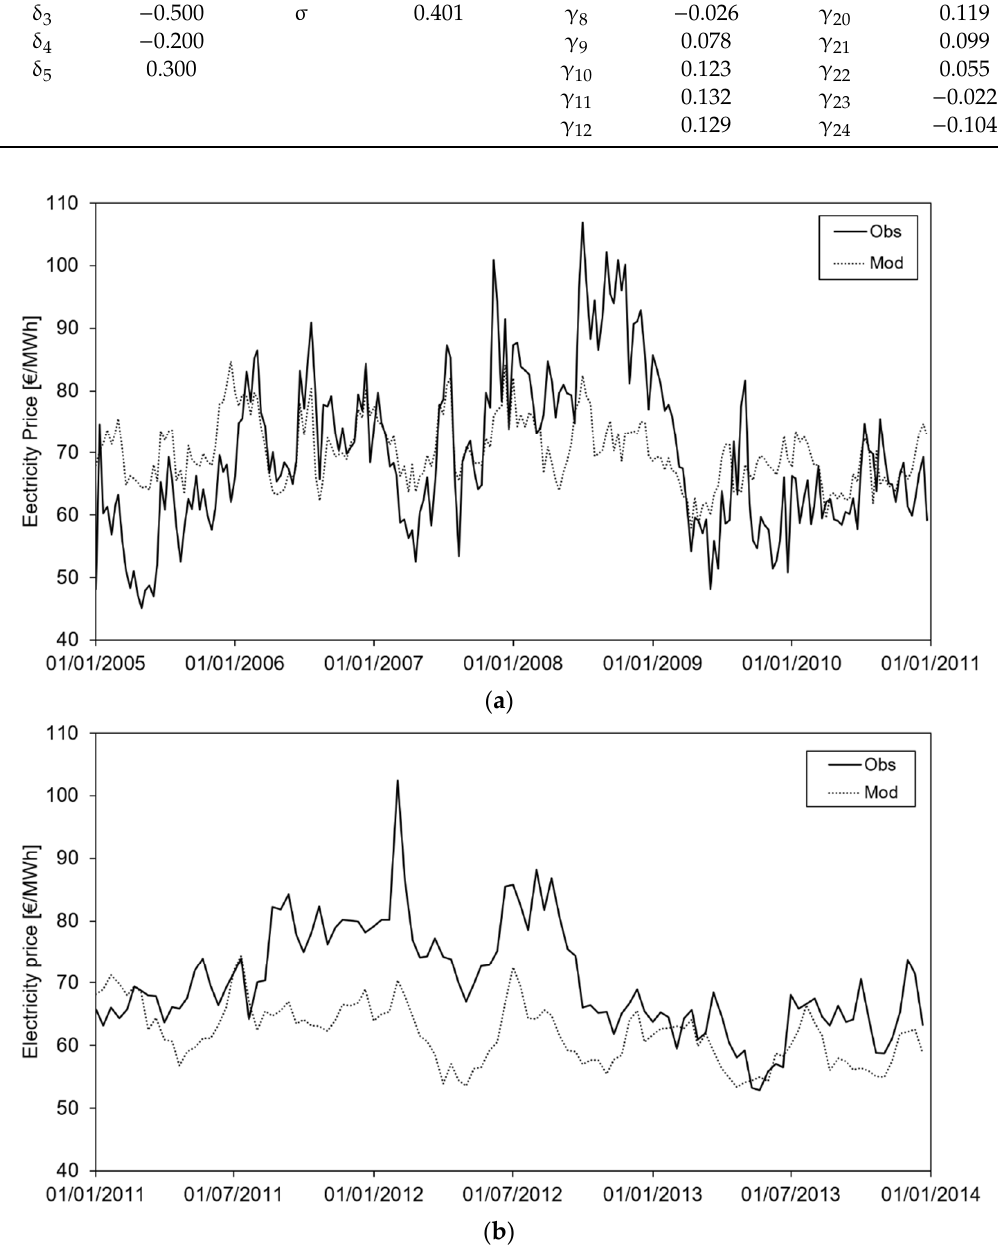
Figure 2. ( a ) Price model calibration; on the x-axis the time period of calibration, on the y-axis the value of electricity price hourly observed and modelled. ( b ) Price model validation; on the x-axis the time period of calibration, on the y-axis the value of electricity price hourly observed and modelled.